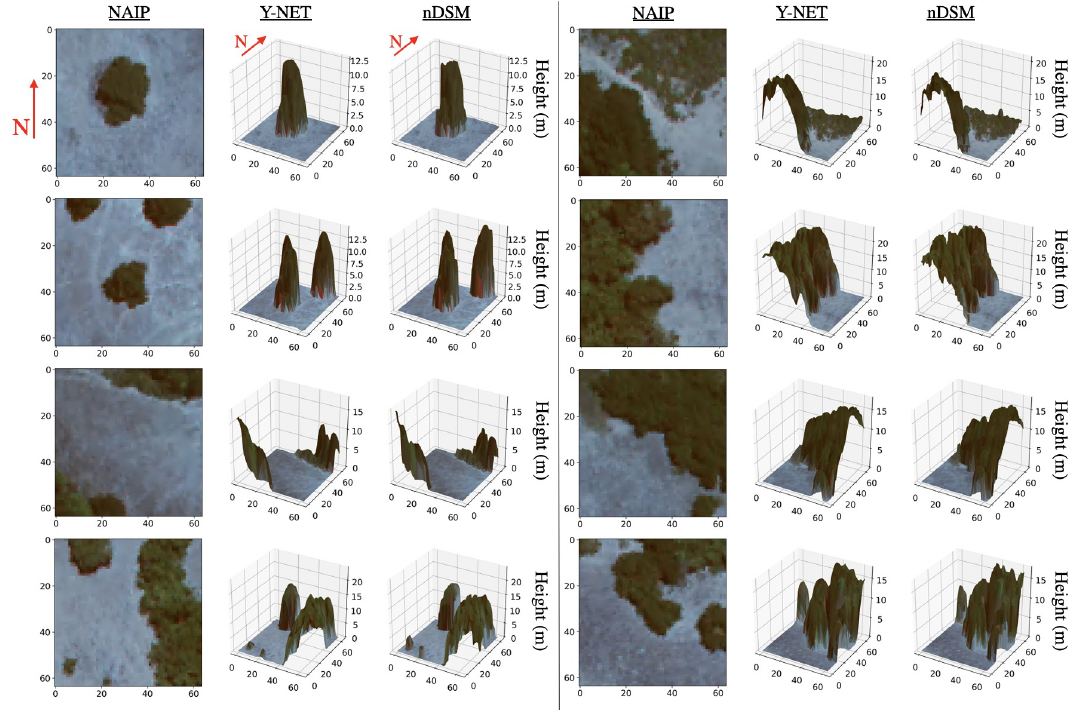
Figure 9. 3D comparisons of Y-NET’s VSM and the corresponding nDSM. We include multiple examples with different vegetation densities and height to show the modeling performance of Y-NET over a broad range of